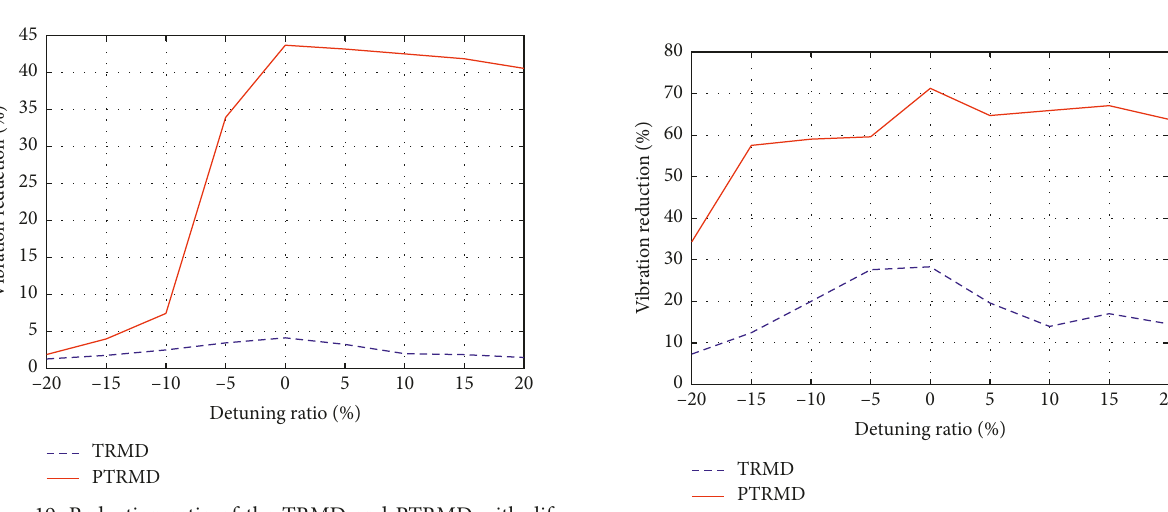
Figure 22: Reduction ratio of TRMD and